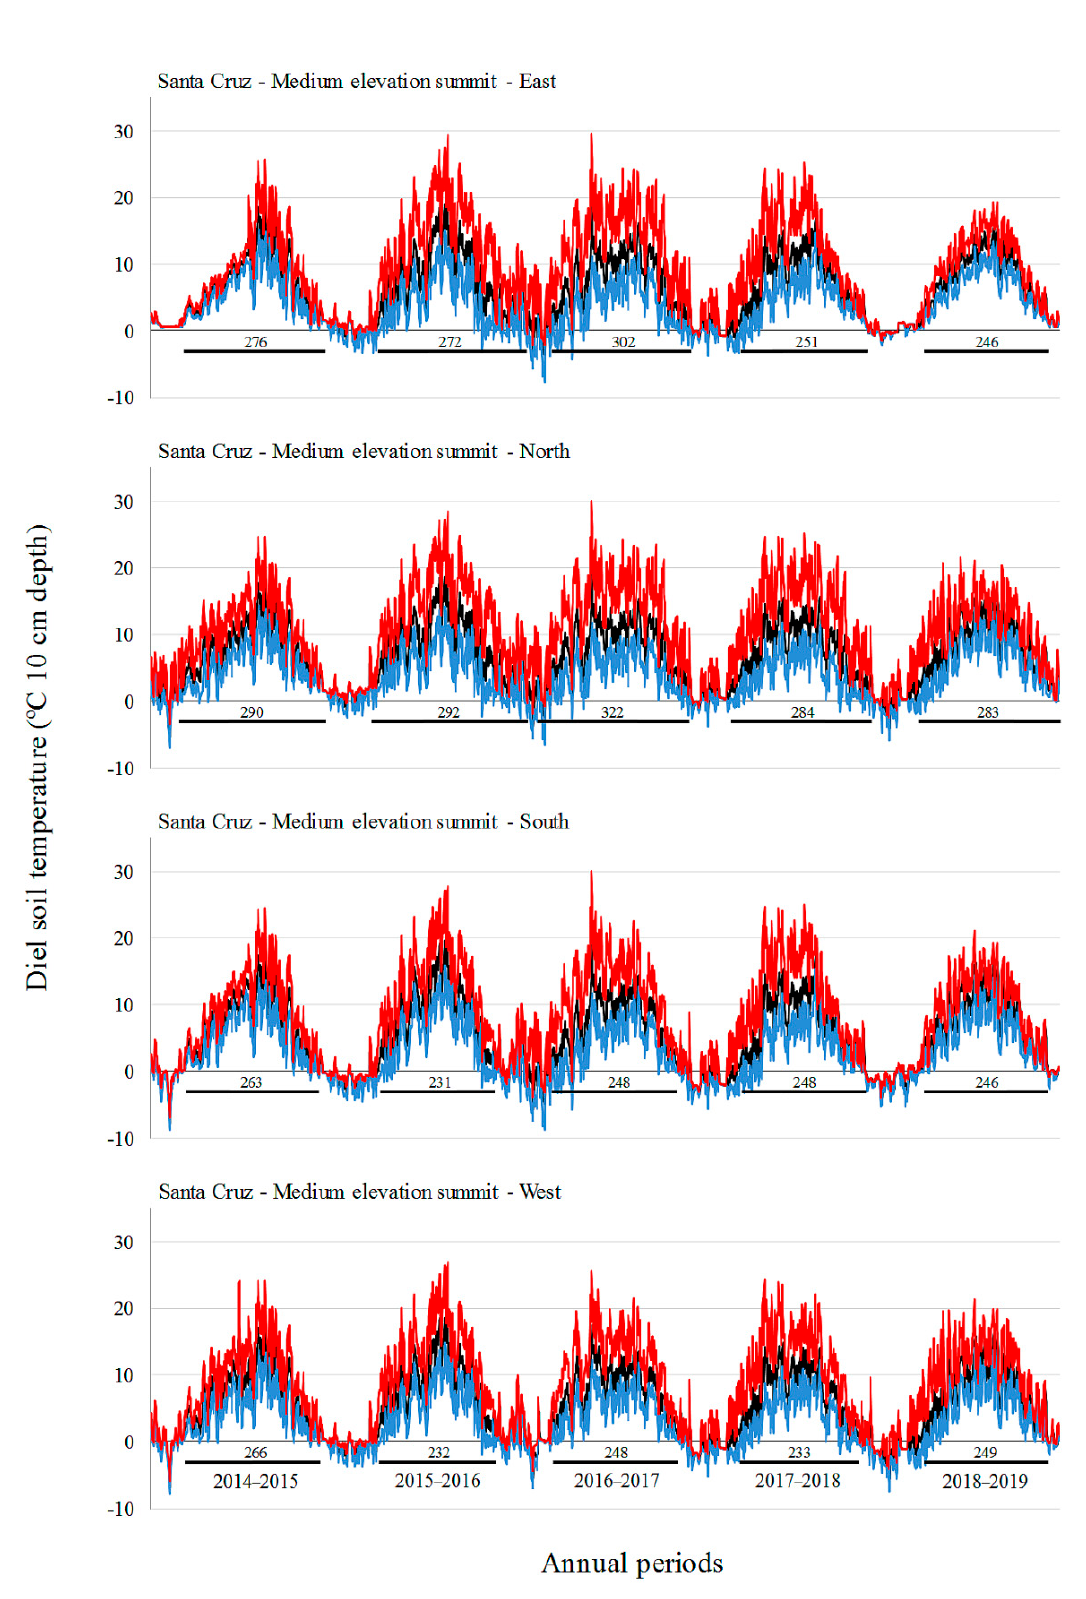
Figure A2. Diel soil temperature ( ◦ C) variation at 10 cm depth during the five studied annual periods (2014–2015 to 2018–2019) on medium elevation summit in Santa Cruz, showing separately different cardinal aspects (east, north, south, west). The length of the growing season is also indicated with horizontal black bars (numbers represent days). Black = mean temperature; blue = minimum temperature, and red = maximum temperature.